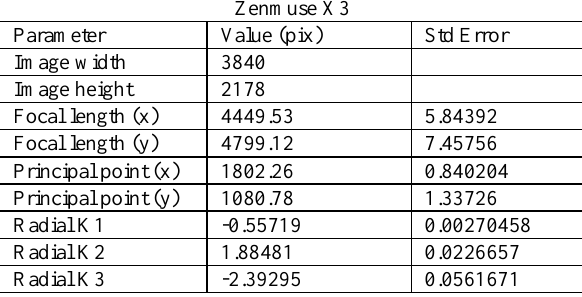
Table 1. Calibration parameters of the Zenmuse X3 camera in Agisoft Lens.